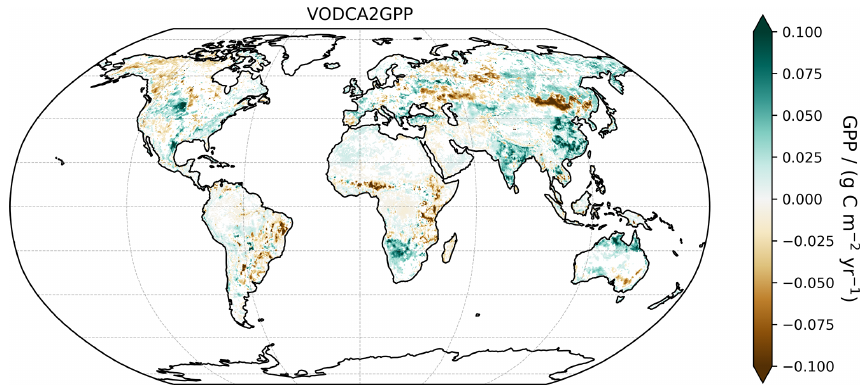
Figure 9. Global map of yearly median GPP trends for the period 1988–2019 for VODCA2GPP. White indicates non-significant